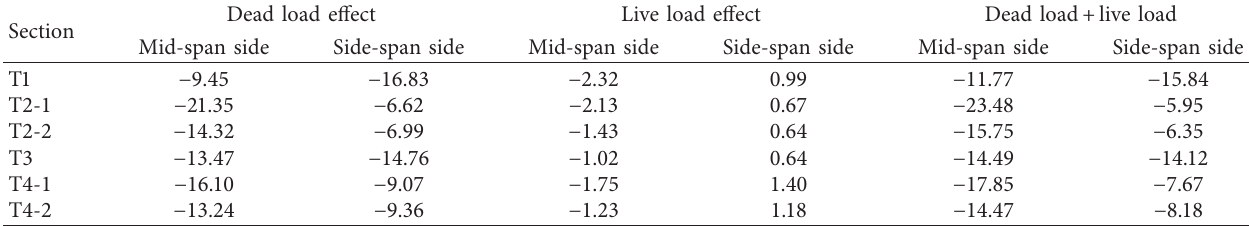
Table 3: Summary of maximum stress of each test section of main tower (unit: MPa).